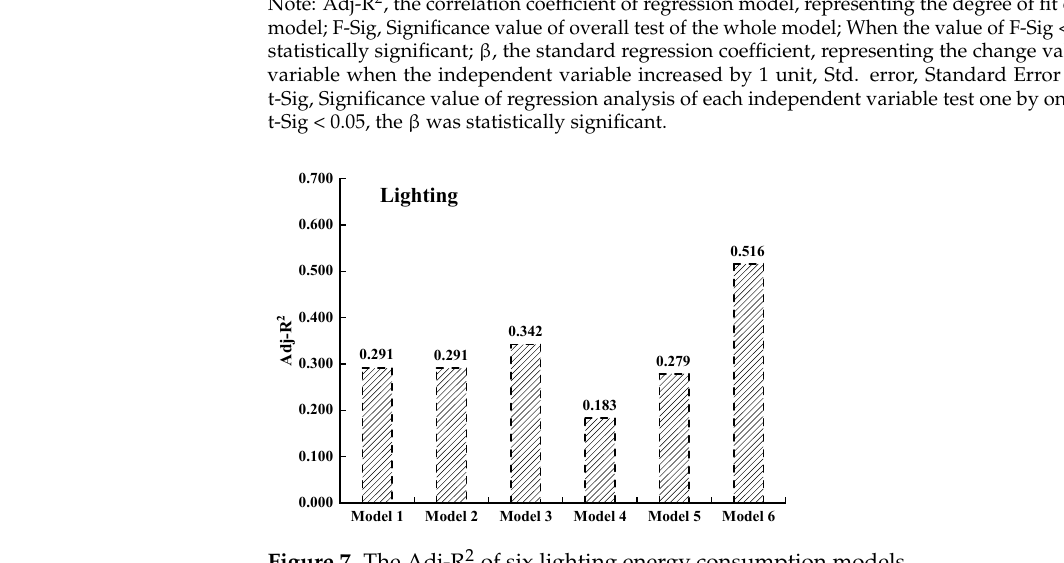
Figure 7. The Adj-R 2 of six lighting energy consumption models. Model 3 only considered household factors, FM_no (number of family members), and their Adj-R 2 was 0.342. In model 4, if considering lifestyle factors only, the valid of 0.183. In term of model 5, only equipment factors were taken into account, the valid variables (AIR_no (number of air conditioners) and Lighting_h (average daily lighting hours)) were found, with an Adj-R 2 of 0.279. As for model 6, if total variables were